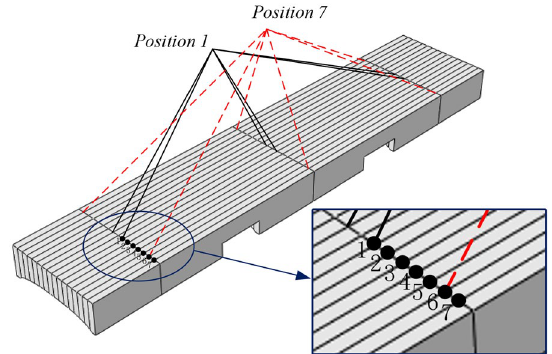
Figure 6 Positions of multiple concentration force application